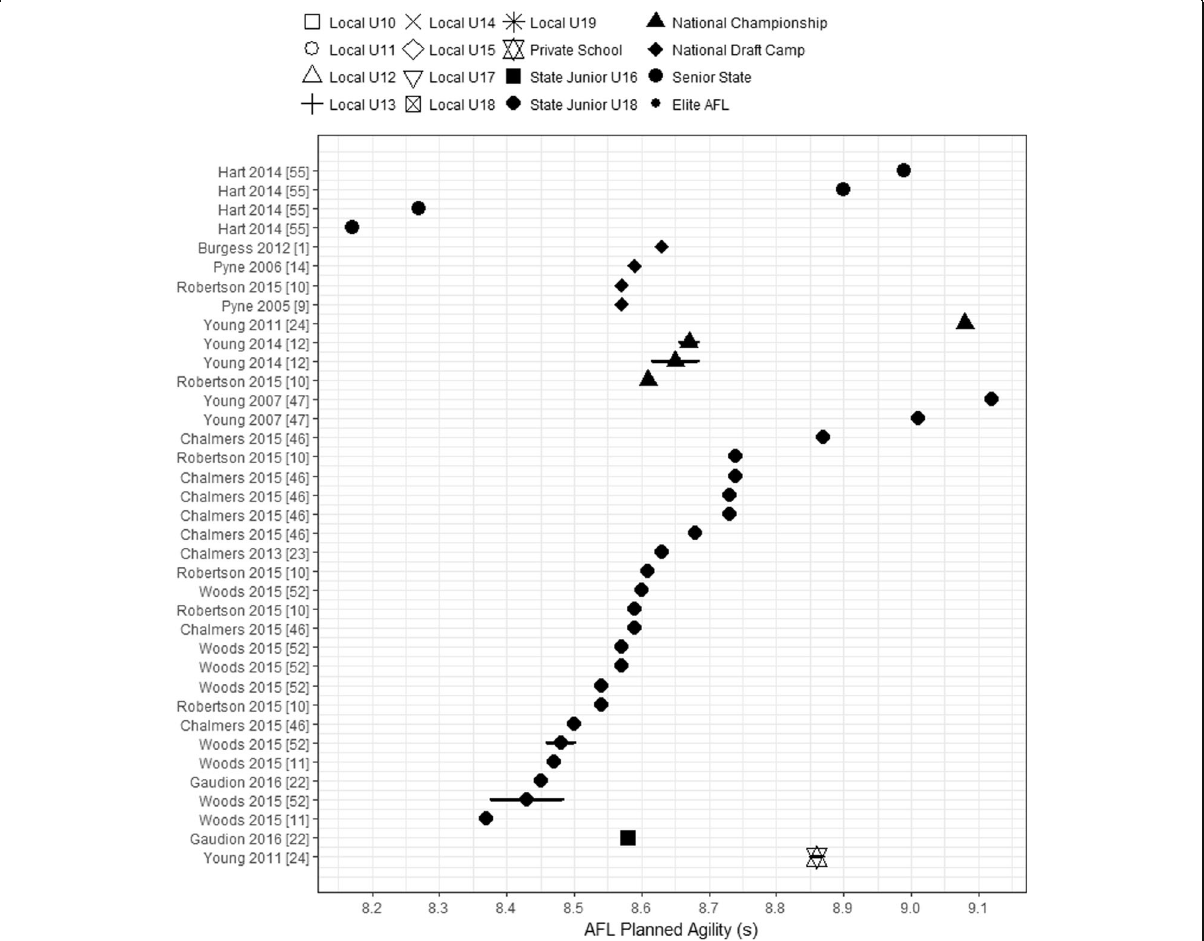
Fig. 4 Mean and CIs of reported AFL planned agility times across the AFL participation pathway levels. Values are ordered by position in AFL participation pathway, then by sample size reported for each group. All players ’ levels are shown in the legend for consistency though not all levels may have data on the charted performance measure. AFL Australian Football League, U